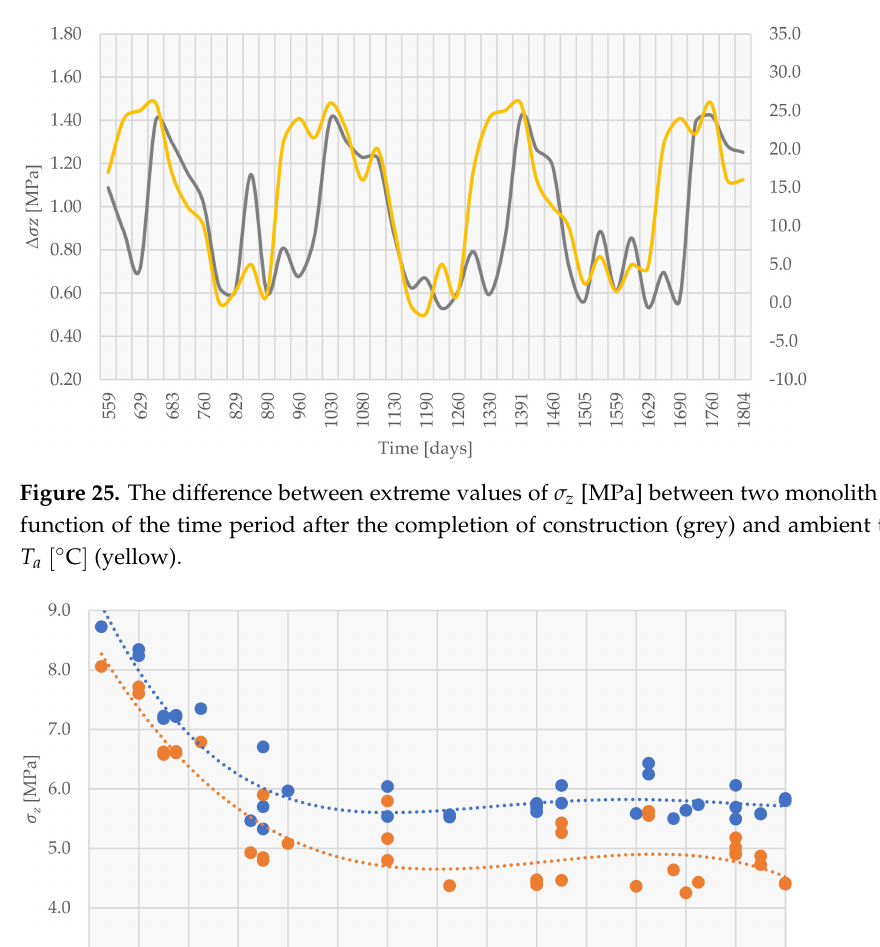
Figure 24. Extreme values of σ z [MPa] as a function of the time period after the completion of construction (blue—monolith length 20.0 m; orange—monolith length 15.0 m; yellow—ambient temperature T a [ ◦ C ] ).